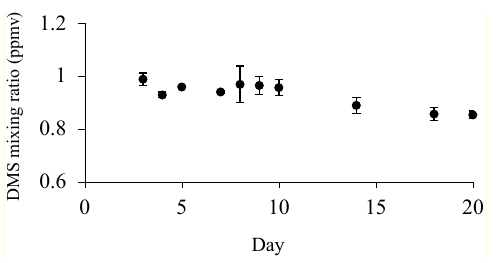
Figure 3. DMS mixing ratios vs. Tenax storage days. Error bars indicate the SD for each